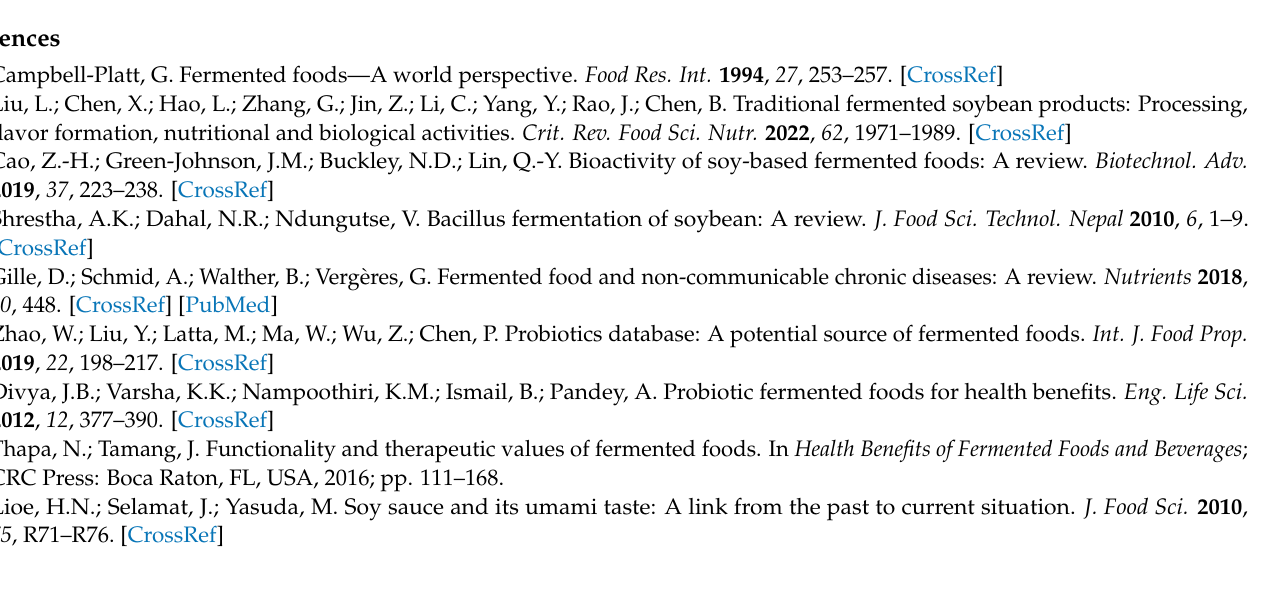
Table S4: Pearson correlation coefficient between sensory characteristics and metabolite